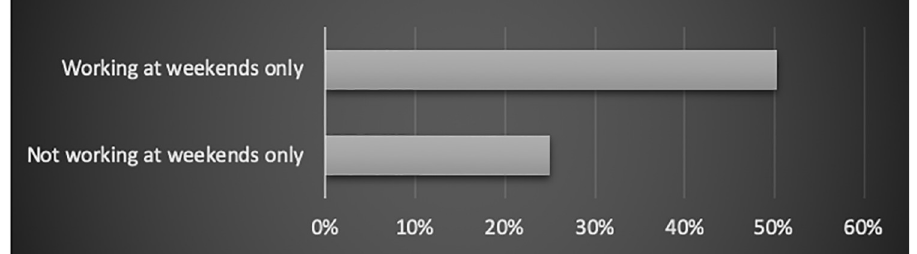
Fig 5. The relation between working at weekends only and not doing so, and employees’ work-life balance (% of people in the category).